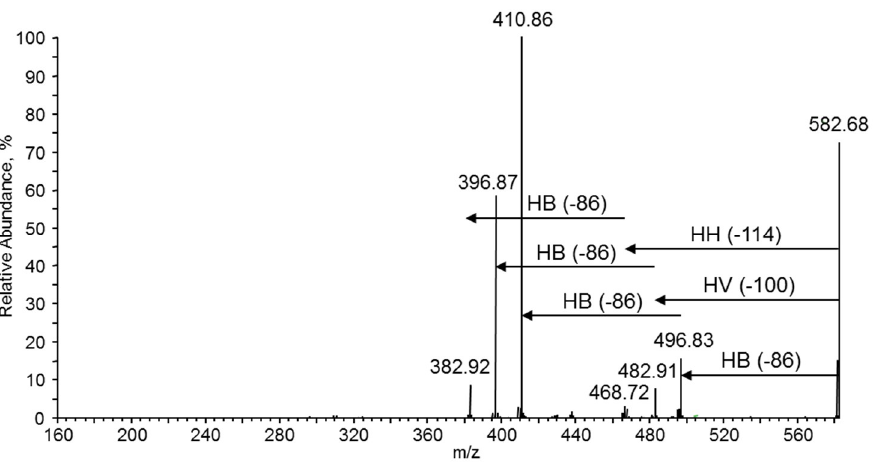
Figure 12. ESI-MS/MS spectrum acquired for the selected potassium adduct of oligomers at m/z 583. Scheme 2 presents the proposed fragmentation paths for the parent ion of m/z 583 shown in Figure 12.